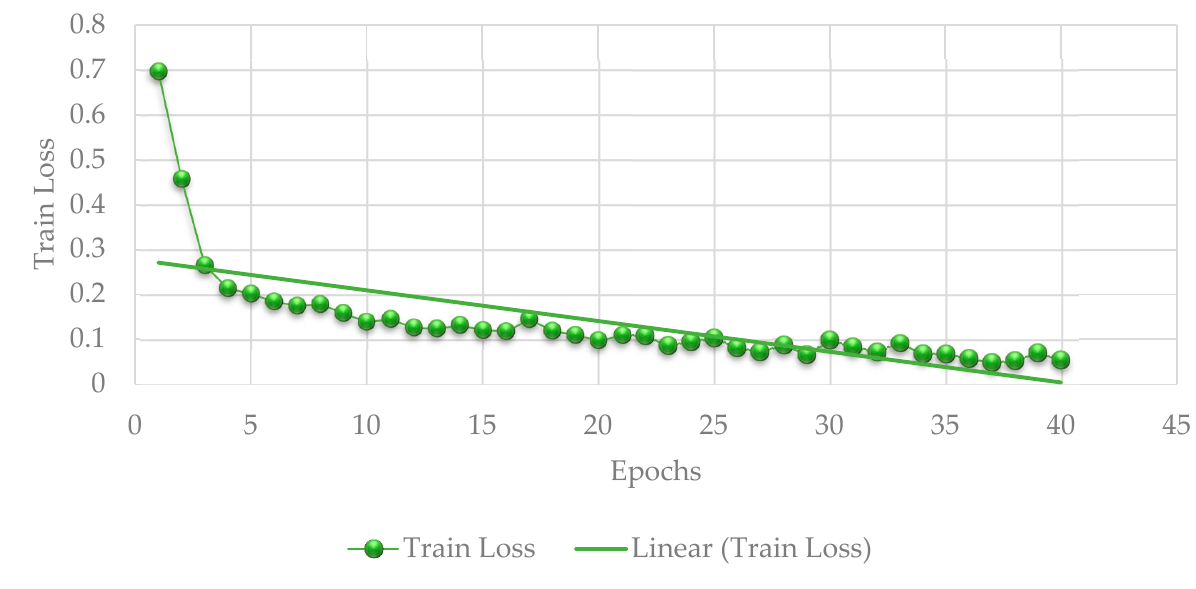
Figure 10. Graph showing test accuracy vs. epoch characteristics.